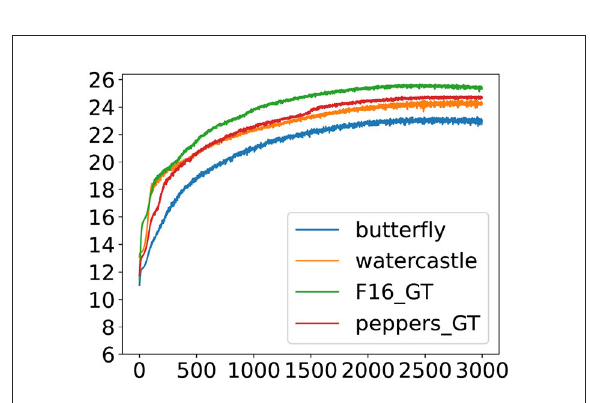
FIGURE5 One of the experiments with the best results for all four images at the epoch 3,000. This figure shows the PSNR curve.